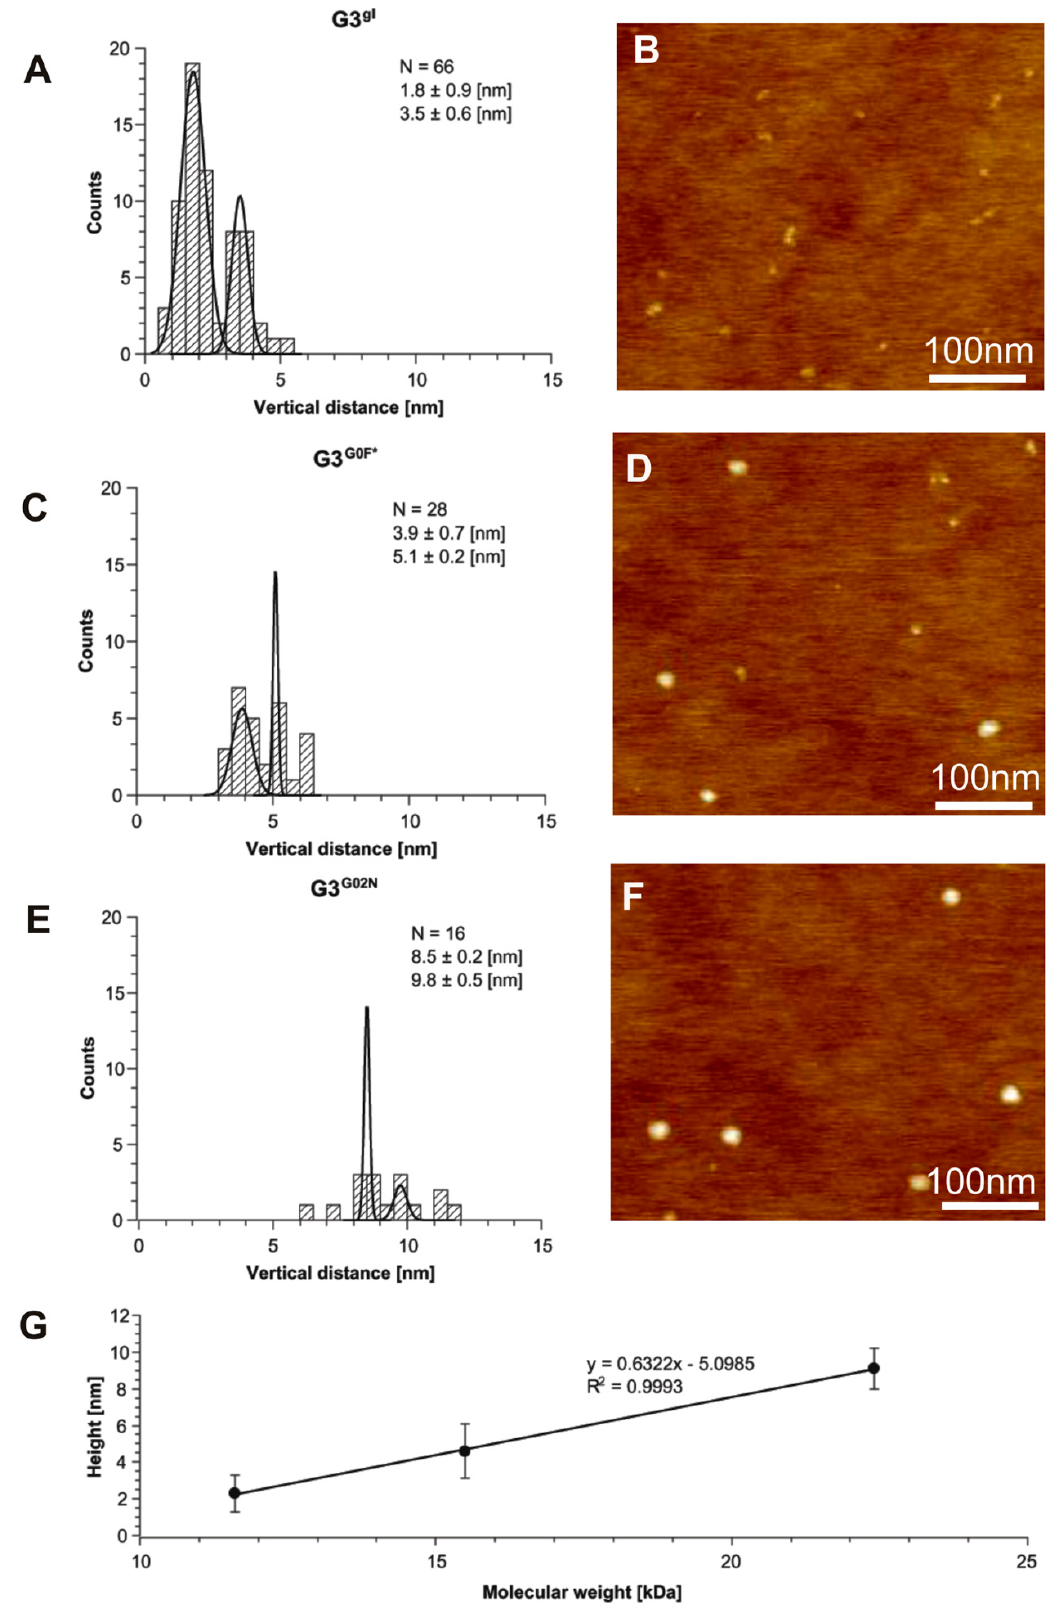
Figure 4. AFM images with height diagrams of dendrimers: ( A , B ) G3 gl ; ( C , D ) G3 G0F ; ( E , F ) G3 G02N ; ( G ) Linear relationship of the dendrimer’s height as a function of its molecular weight with high correlation coefficient (R 2 = 0.9993).